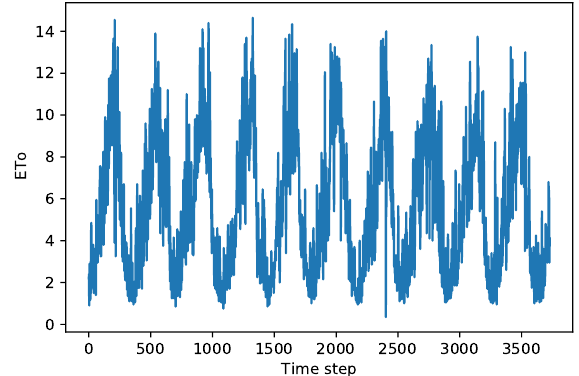
Figure 8. ETo calculated by